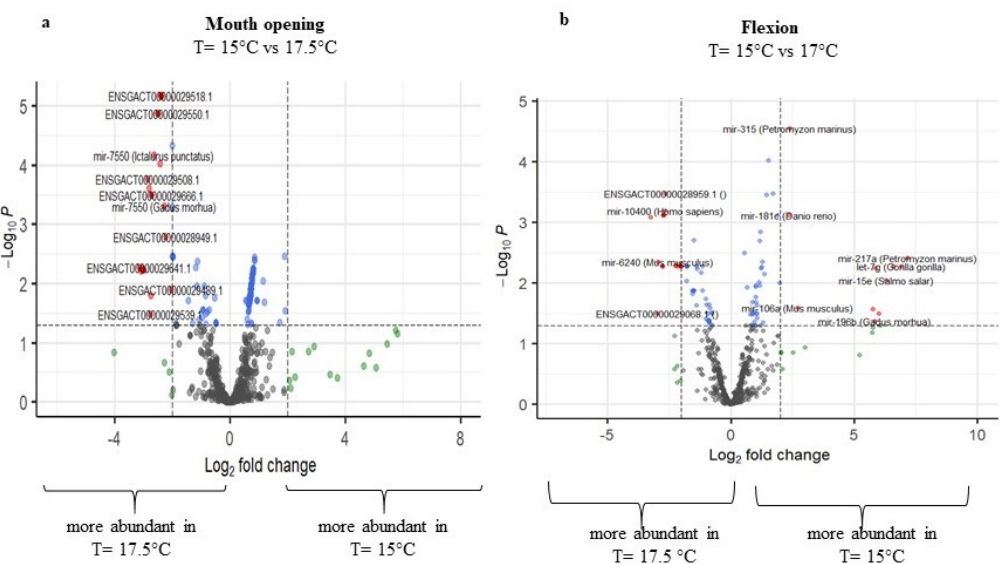
Figure 5. Volcano plots of transcript expression values at T = 15 °C and T = 17.5 °C at ( a ) mouth opening and ( b ) flexion stage. In grey color, not significant expression values are shown, in green expression, values with log2FC value > 2, in blue expression, values with padj < 0.05, and in red expression, values with padj < 0.05 and log2FC > 2 (n = 3–4).